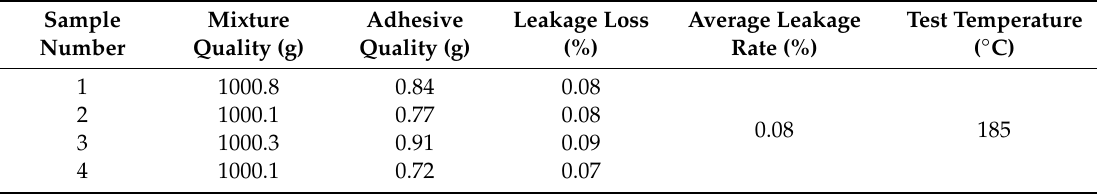
Table A2. The leakage test results of